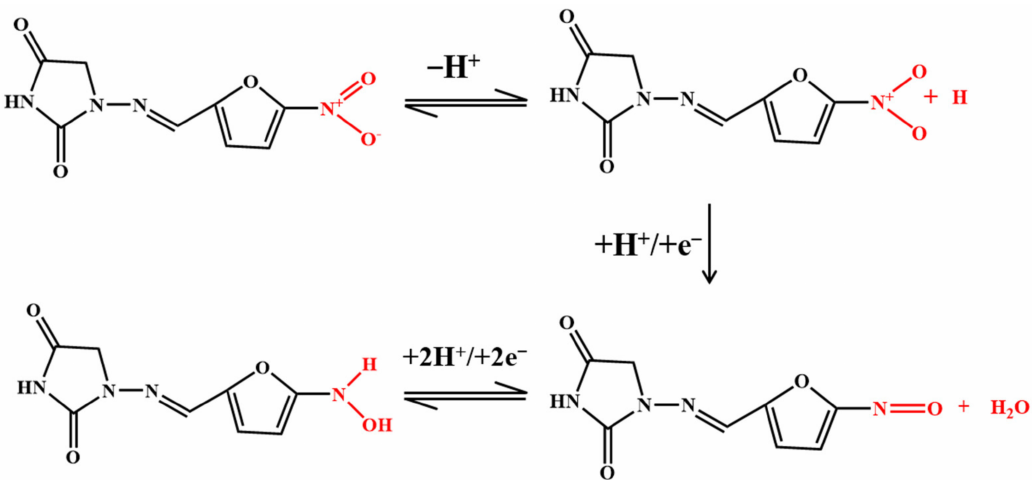
Figure 6. Mechanism for the electrochemical oxidation of